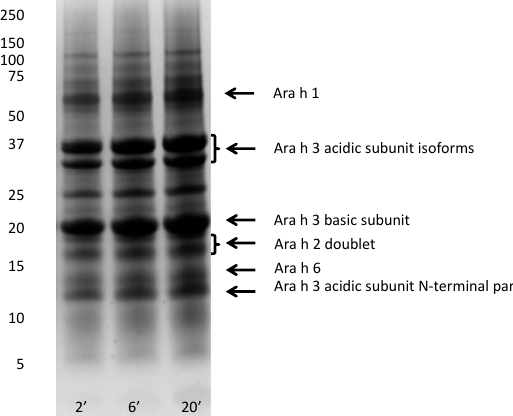
Figure 3. Protein profiles of light roasted peanut flour extracted with artificial saliva (pH = 7.8). Extraction time up to 20 min. Protein profiles were determined by SDS-PAGE, under reducing conditions, on 10% gels. The molecular weight marker is indicated on left in kDa, numbers at the bottom indicate extraction time (minutes). Arrows on the right margin point to major allergens.